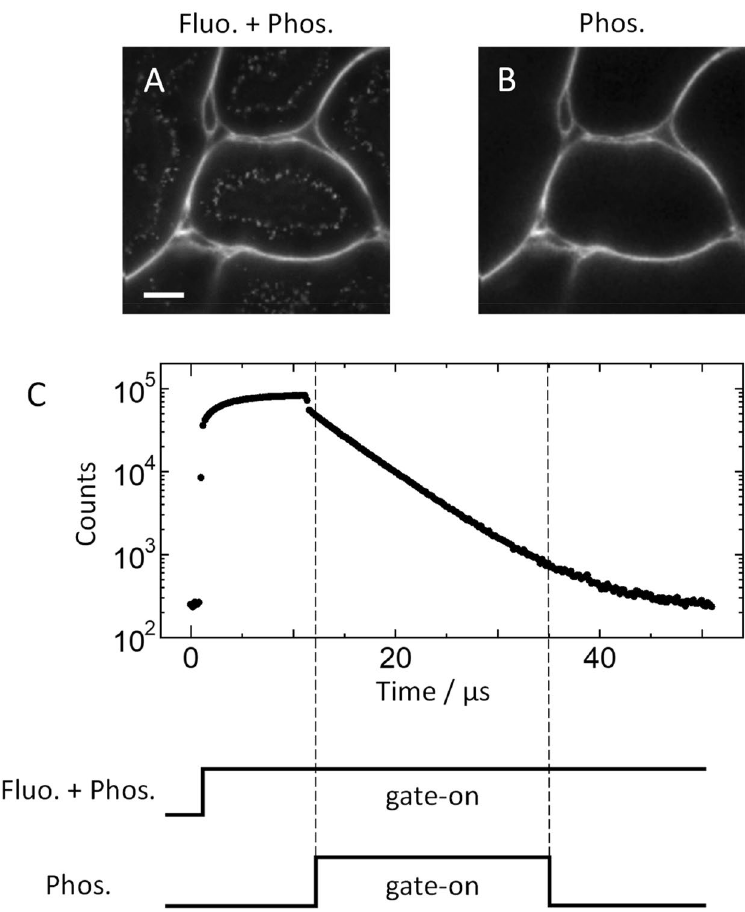
Figure 5. Elimination of autofluorescence from kidney using the time gating method. ( A ) Luminescence intensity image of BTQ-R 12 including tissue autofluorescence and ( B ) its gated image. Scale bar 20 μm. ( C ) Luminescence decay curve of the total pixels in image ( A ). The schematic shows the time domains of ( A ) and ( B ). The dashed lines show the start and end of the time gate. Gate: 12–35